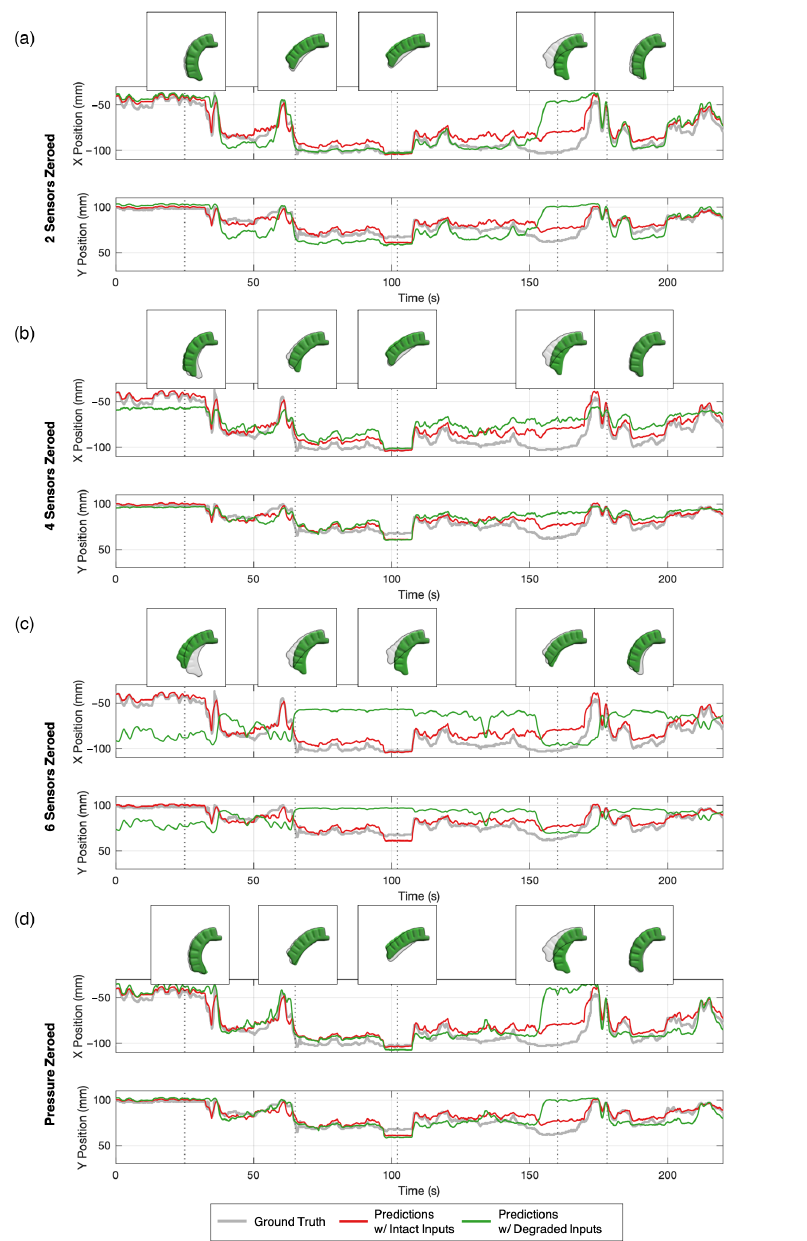
Figure 4. Plots of the tip position in X and Y in mm and snapshots of the pose of the sensor–actuator when estimated under various states of sensor degradation: ( a ) the voltage readings from the resistance-based sensors when the first two bellows from the tip of the sensor-actuator are saturated, ( b ) the first four sensors from the tip are saturated, ( c ) all six resistance-based sensors are saturated, leaving only the pressure reading intact, and ( d ) only the pressure sensor is